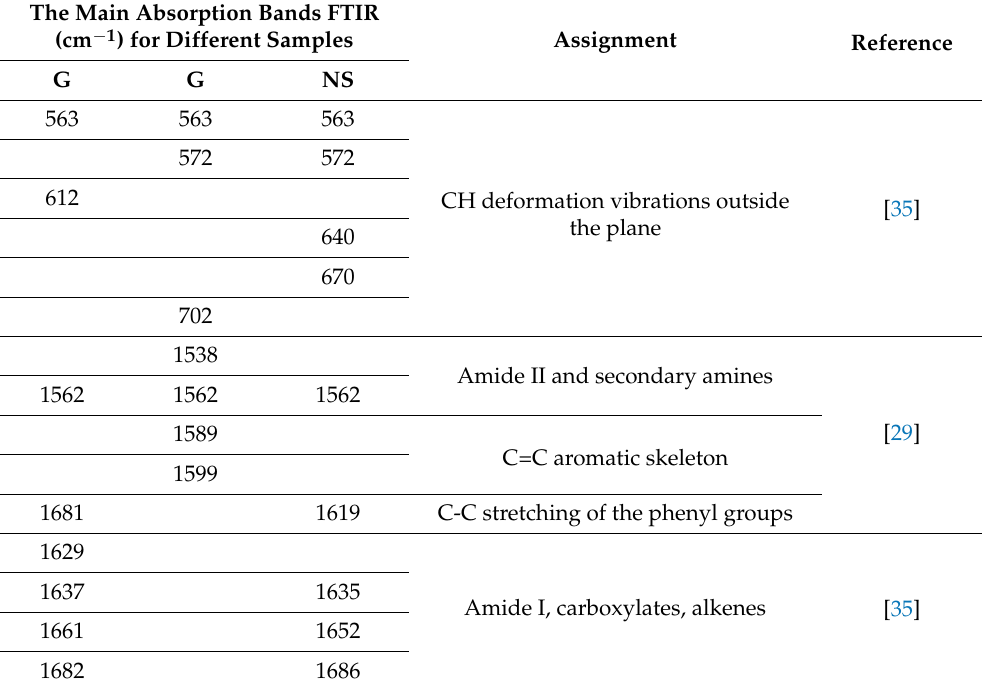
Table 6. Attribution of the main FTIR absorption bands for nutrient agar medium (G), anaerobic stabilized treatment sludge (N) and anaerobically stabilized treatment sludge treated by autoclaving (NS) [34].